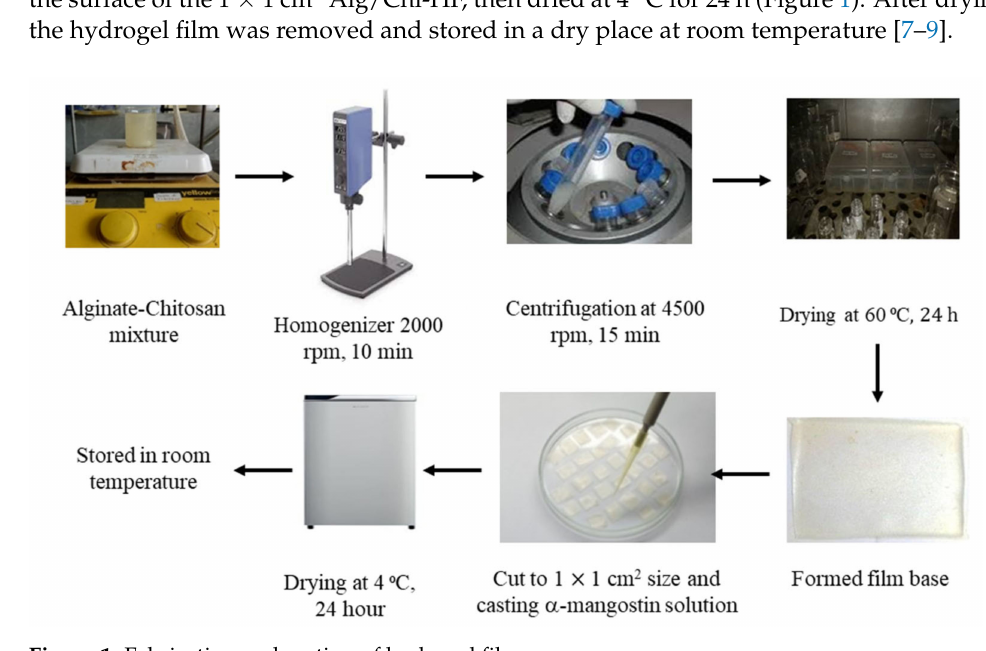
Figure 1. Fabrication and casting of hydrogel